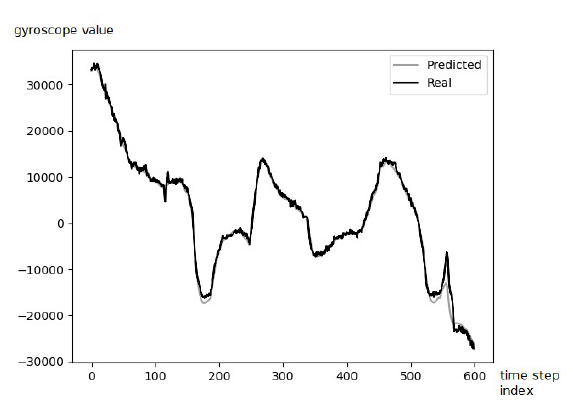
Fig. 7. An example of the gyroscope readings – forecasted (grey) and real (black) values applying the stacked LSTM